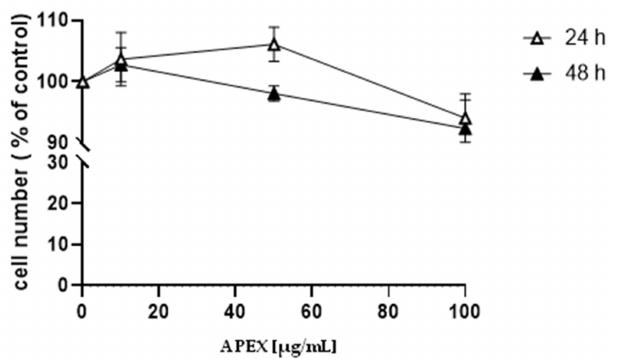
Figure 1. Effect of APEX on U937 cell growth. U937 cells were treated with increasing concentrations of APEX for 24 h and grown for a further 24 and 48h in APEX-free medium. The number of viable cells was then determined using the trypan blue exclusion assay. Values represent the means ± SEM (standard error of the mean) of at least three independent determinations.